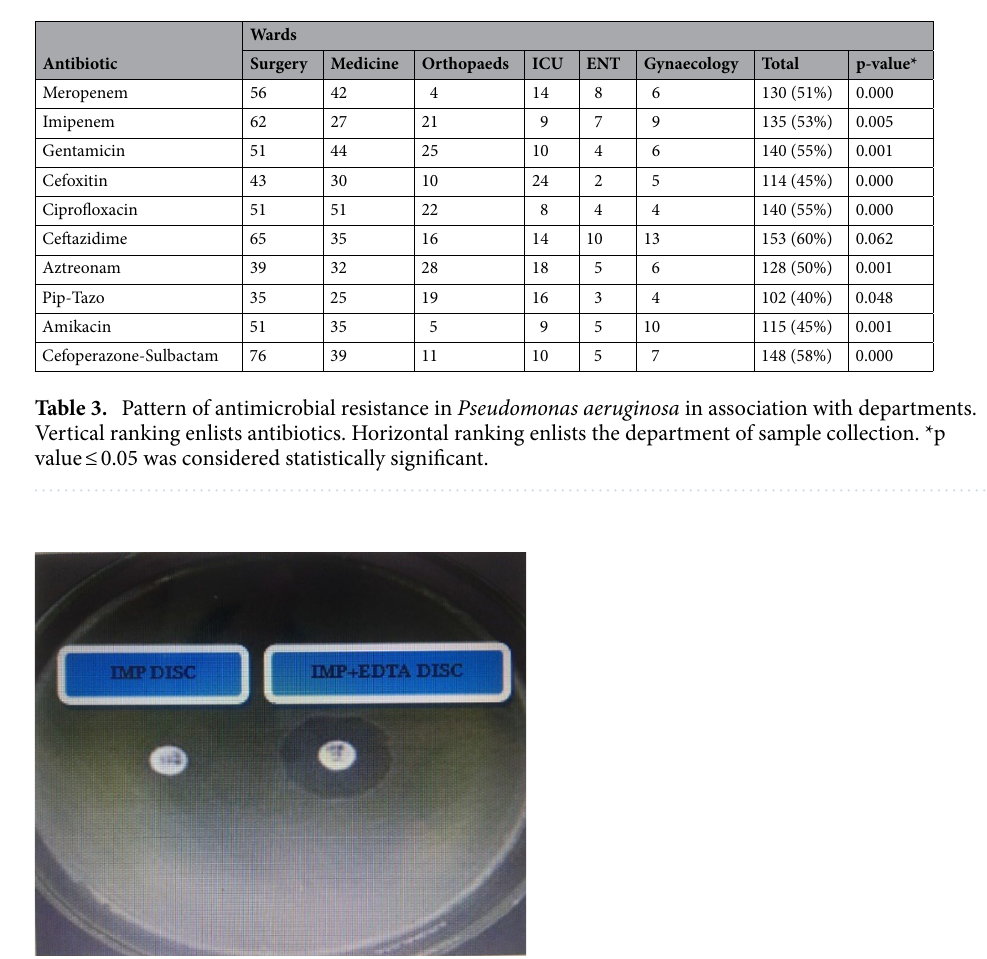
Figure 2. Percentage antibiotic resistance and sensitivity Pseudomonas aeruginosa isolated from patients in Punjab, Pakistan (n = 255).